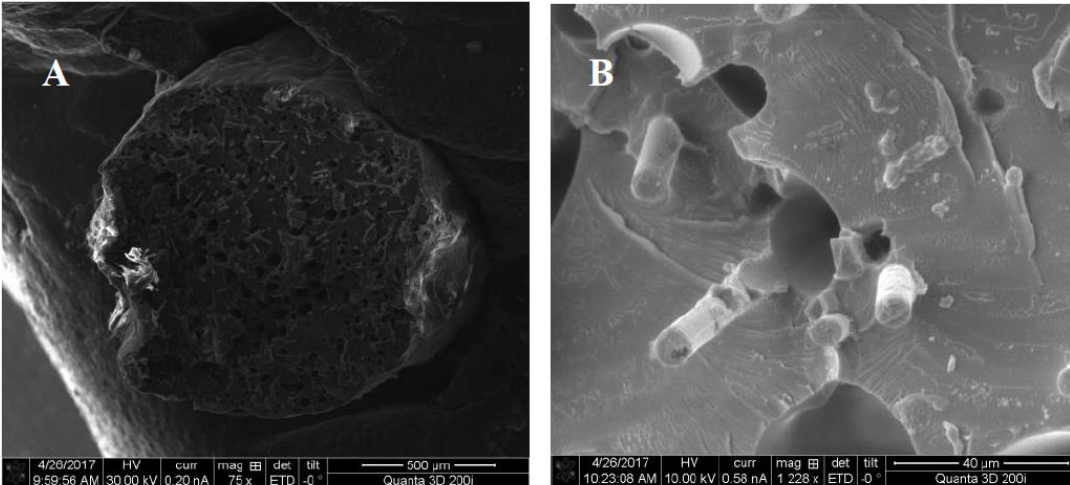
Figure 2. SEM micrograph of the fracture surface of the prepared AF-5 composite material. ( A ) shows the cross-section of the entire string at 75 magnification, and ( B ) shows a fracture area at 1228× magnification.